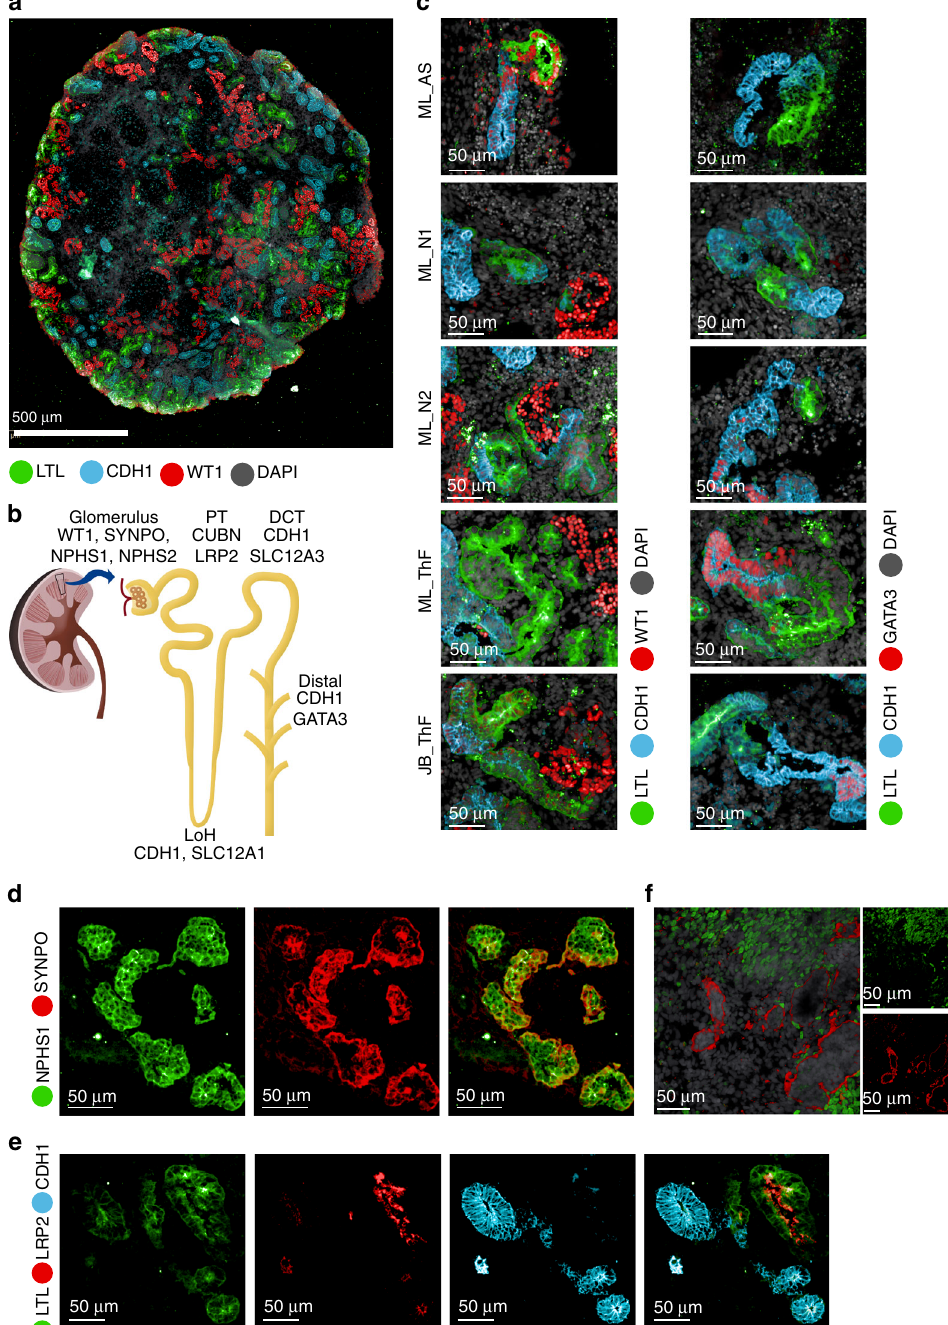
Fig. 2 IF validation of markers derived from the single-cell data in mature kidney organoids. a IF staining of an entire kidney organoid with segment speci fi c markers as shown. b Schematic of kidney nephron with major cell types and canonical markers annotated. c Immuno fl uorescence staining of D29 kidney organoids for podocyte (WT1), proximal tubule (LTL), and distal tubule (CDH1 and GATA3) across two protocols (JB, ML) and four cell lines (AS, N1, N2, ThF). IF staining for validation of markers identi fi ed in the single-cell data: d NPHS1 colocalized with the podocyte-speci fi c marker SYNPO and e LRP2 colocalized with the proximal tubular marker LTL (bottom). f IF staining validation for MEIS1-positive mesenchymal cells in D29 organoids. LAMA1 indicates basement membranes. MEIS1 staining of mesenchymal cells appropriately surrounds LAMA1-de fi ned tubular nephron